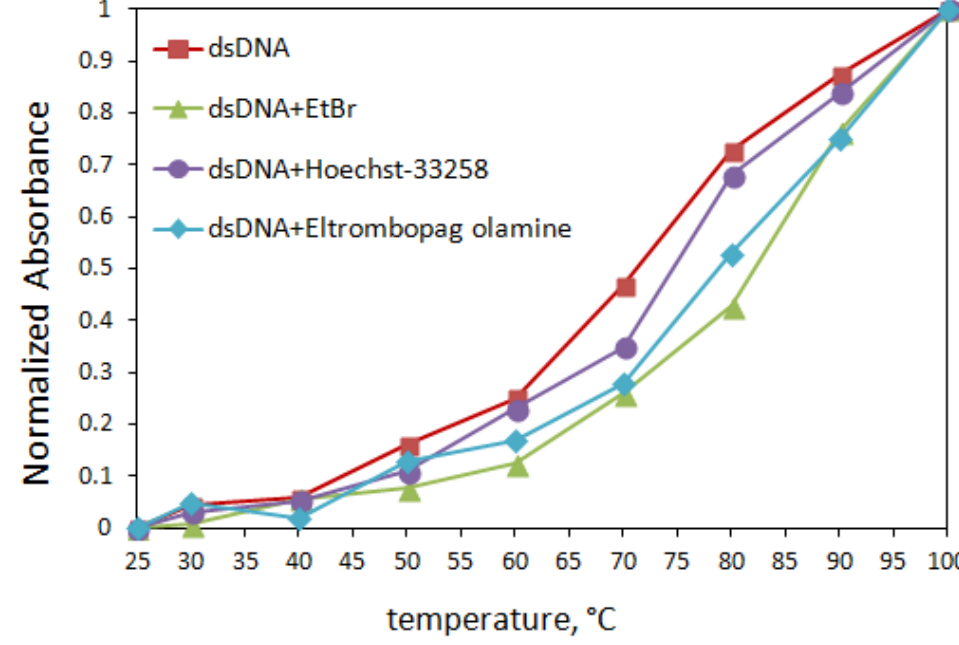
Figure 7. Thermal denaturation curves of dsDNA (120 µM) in the absence and in the presence of ELT and some intercalator/groove agents (10 µM) in Tris/HCl buffer solution. It is known [25] that EtBr binds to dsDNA via intercalation because the stability of the complex formed in the EtBr + dsDNA mixed solution is higher than the groove binders (Rhodamin B: small groove binder, Hoechst-33258: small groove binder, and Methyl Green: large groove binder). This binding significantly increases the thermal denaturation temperature of dsDNA. In contrast, groove-binding agents cannot raise the denaturation